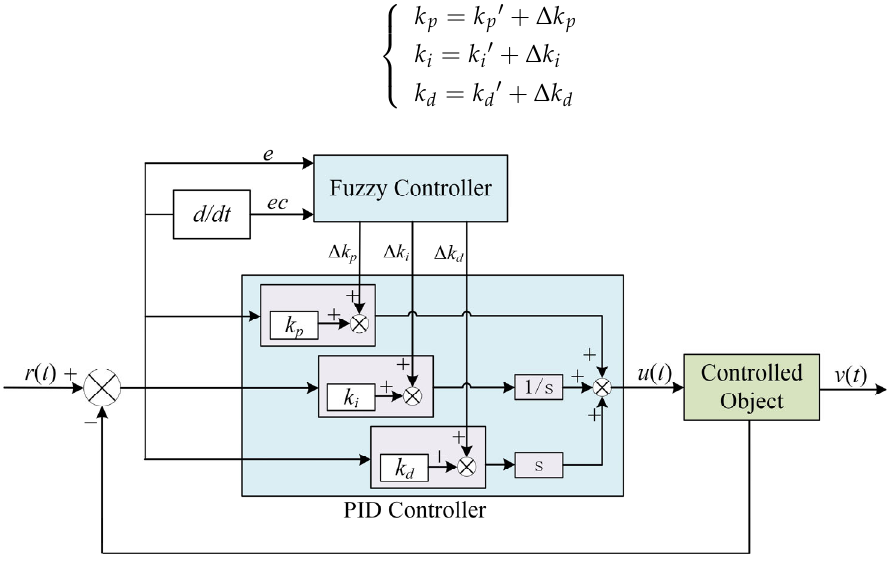
Figure 8. Block diagram of the fuzzy adaptive PID controller [22,23].